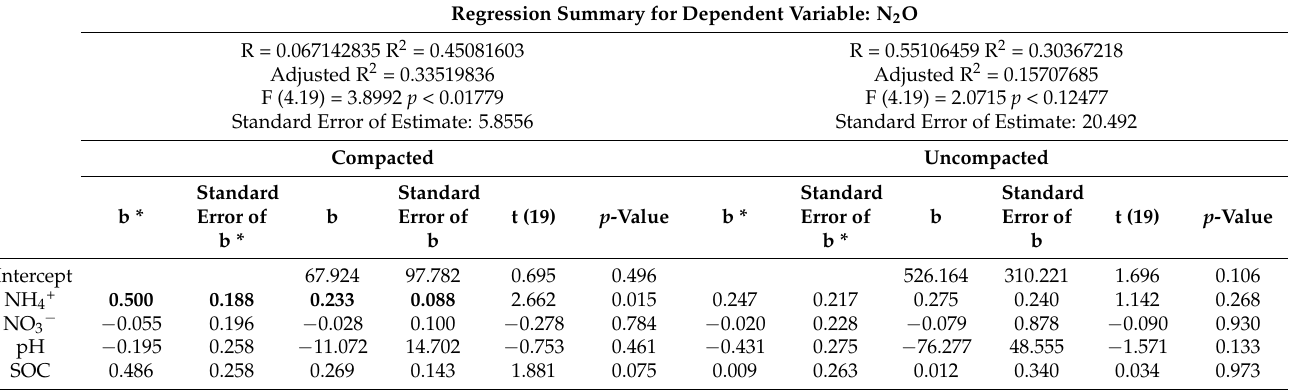
Table 2. Multiple regression models between key soil parameters and N 2 O emissions in compacted and uncompacted Luvisol ( n = 24). Regression Summary for Dependent Variable: N 2 O